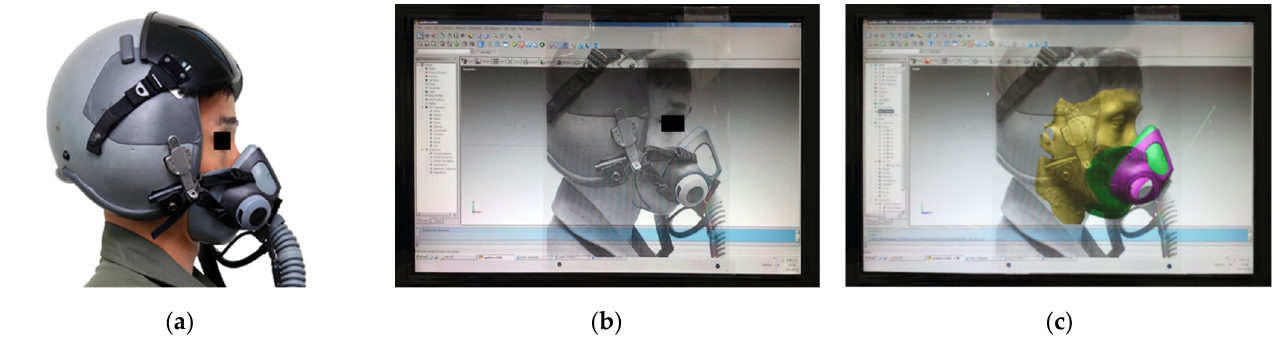
Figure 8. A photo-based placement of the 3D face and mask images for the identification of mask-wearing positions (illustrated). ( a ) A profile photo of a pilot while wearing the MBU-20/P oxygen mask; ( b ) a transparent film with a printed photo placed on the monitor; ( c ) an alignment of the 3D face and mask images to their corresponding images of the printed photo on the film. Table 1. Mask-wearing positions (unit: mm) for four mask size